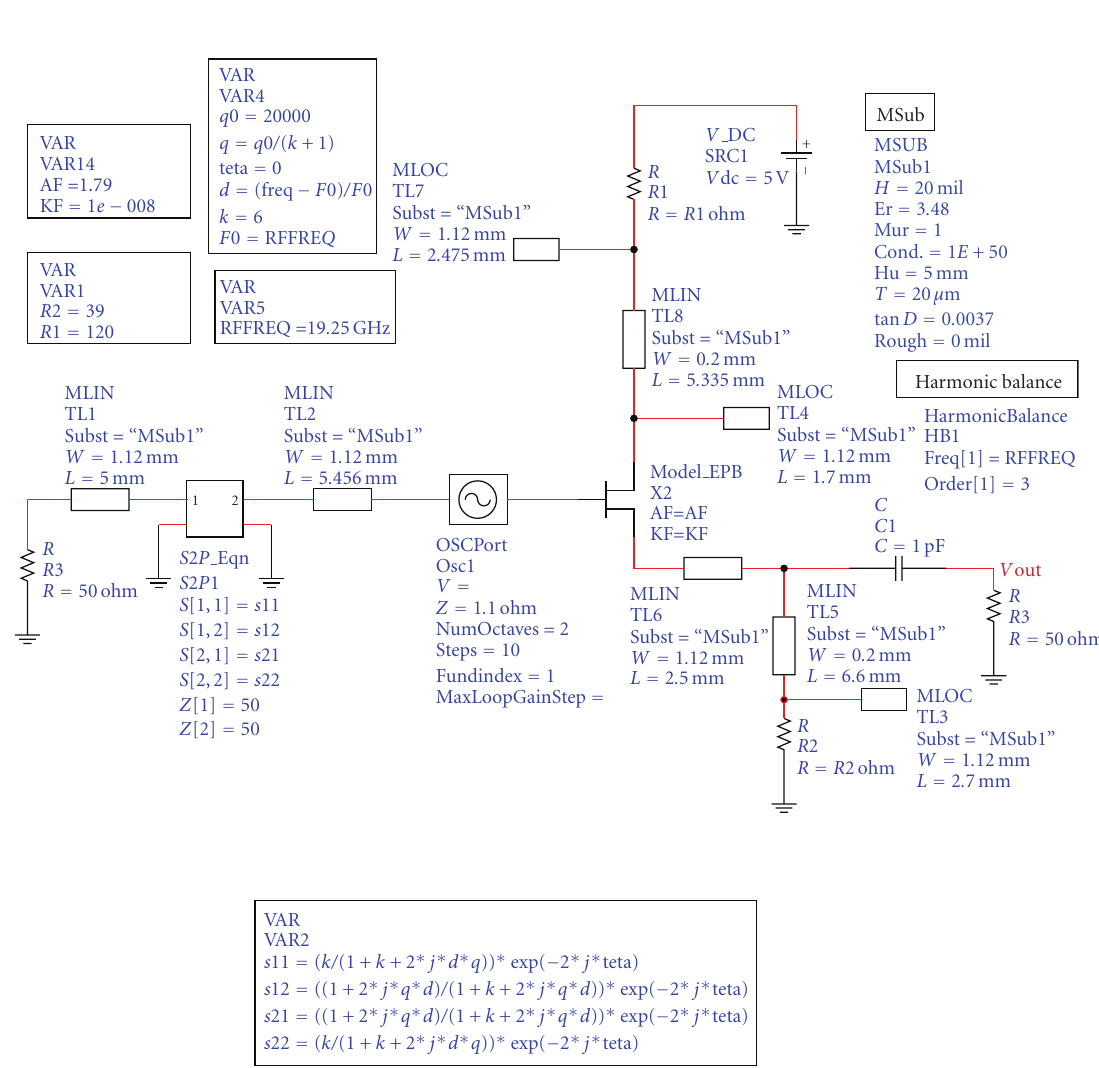
Figure 6: The complete oscillator circuit used for